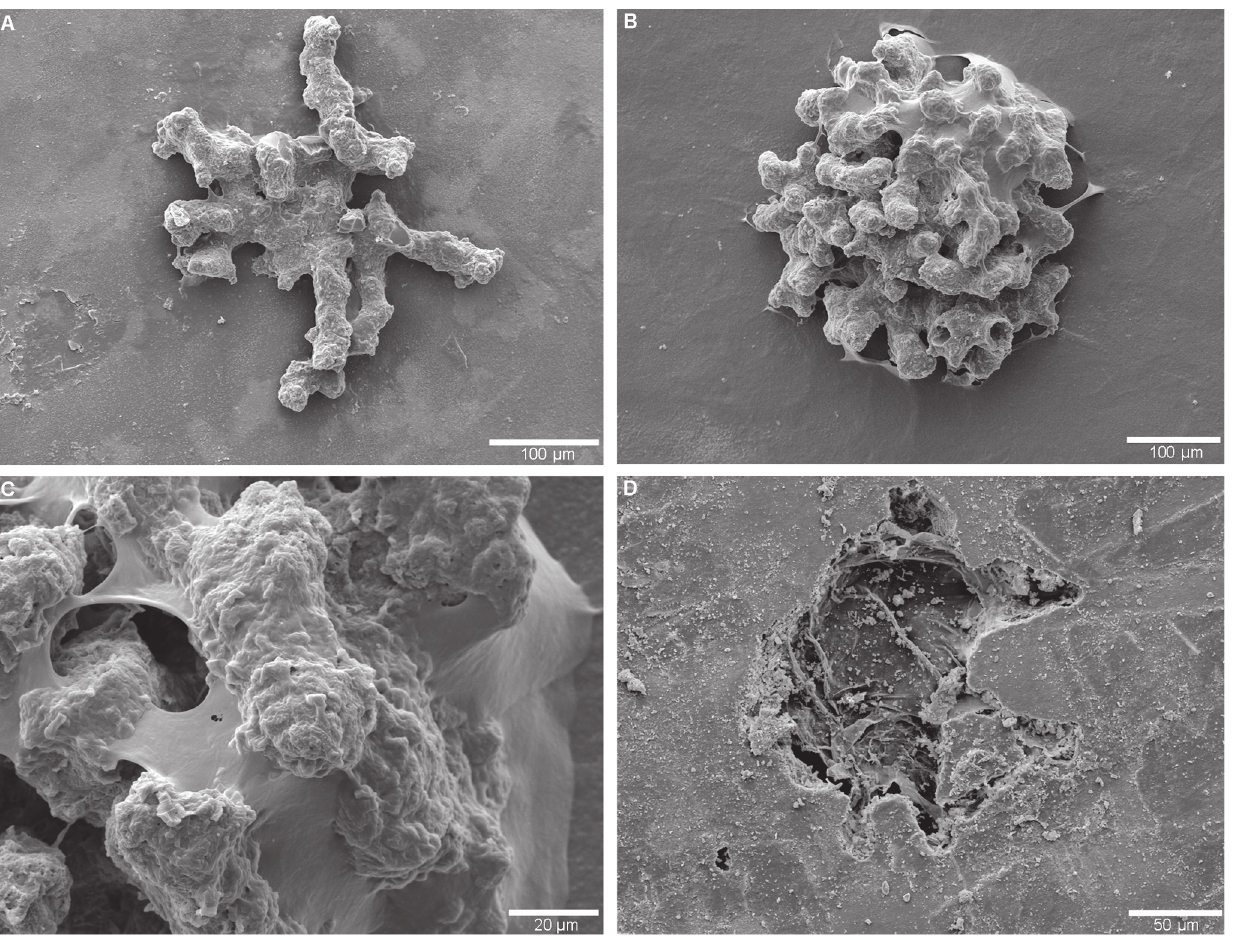
Fig 6. Morphotype 4 in Nautilus macromphalus from New Caledonia. (A) SEM image of initial borings of the foraminifer in an epoxy-resin cast. (B) Mature morphology with numerous irregularly branching galleries forming a hemispherical plexus. (C) Close-up of galleries displaying their irregular surface texture. (D) SEM-photograph of shell surface illustrating the entrance of the foraminiferan